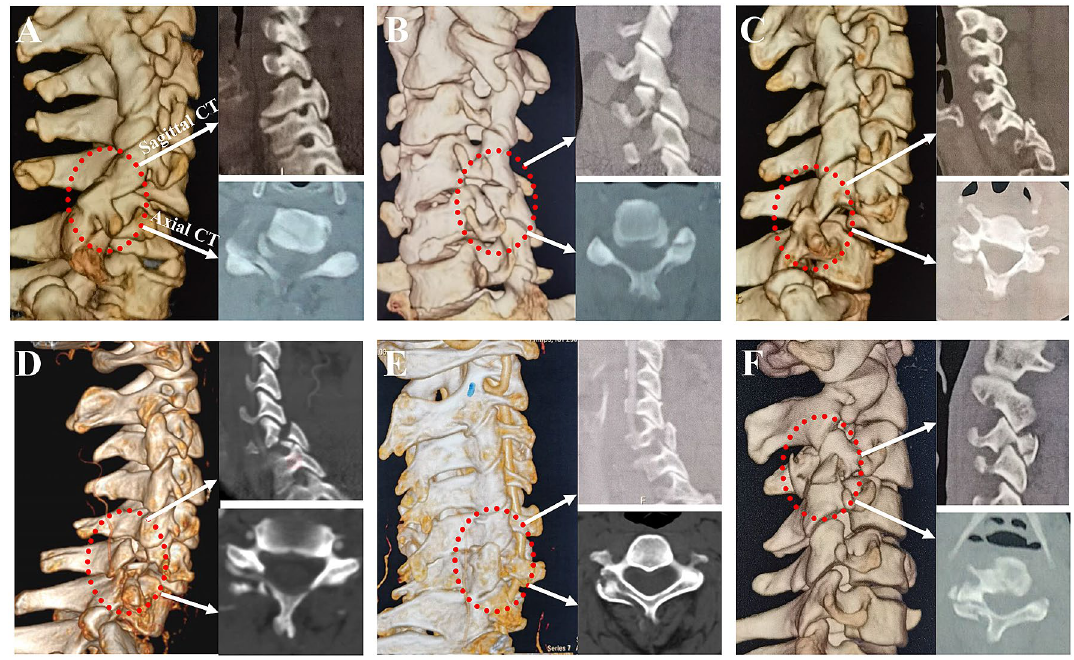
Figure 2. Description of the classification of UCLF. Type I: defined as unilateral cervical locked facet without lateral mass-facet fracture ( A ); Type II A : unilateral cervical locked facet with ipsilateral superior articular process fracture of the injury segment ( B ); Type II B : unilateral cervical locked facet with ipsilateral inferior articular process fracture ( C ); Type II C : unilateral cervical locked facet with ipsilateral both superior and inferior articular process fractures ( D ); Type III A: unilateral cervical locked facet with ipsilateral lateral mass splitting fracture ( E ); Type III B: l unilateral cervical locked facet with ipsilateral lateral mass comminuted fractures ( F